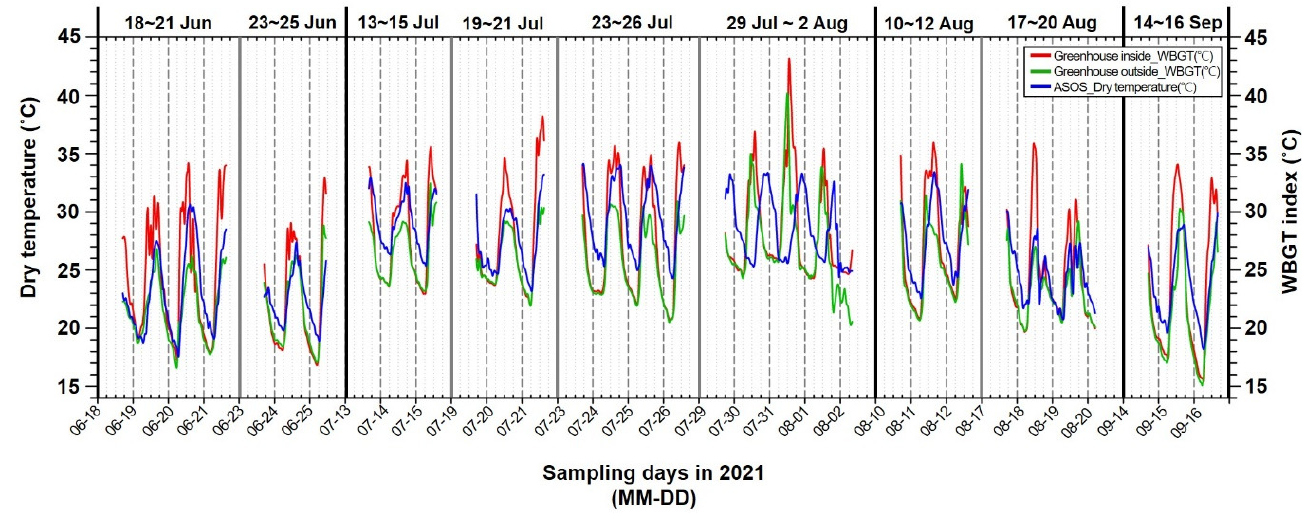
Figure 3. Time-series graphs of the wet-bulb globe temperature (WBGT) index inside and outside greenhouses and of the dry-bulb temperature from Automated Synoptic Observing Systems (ASOS) data for 2021.